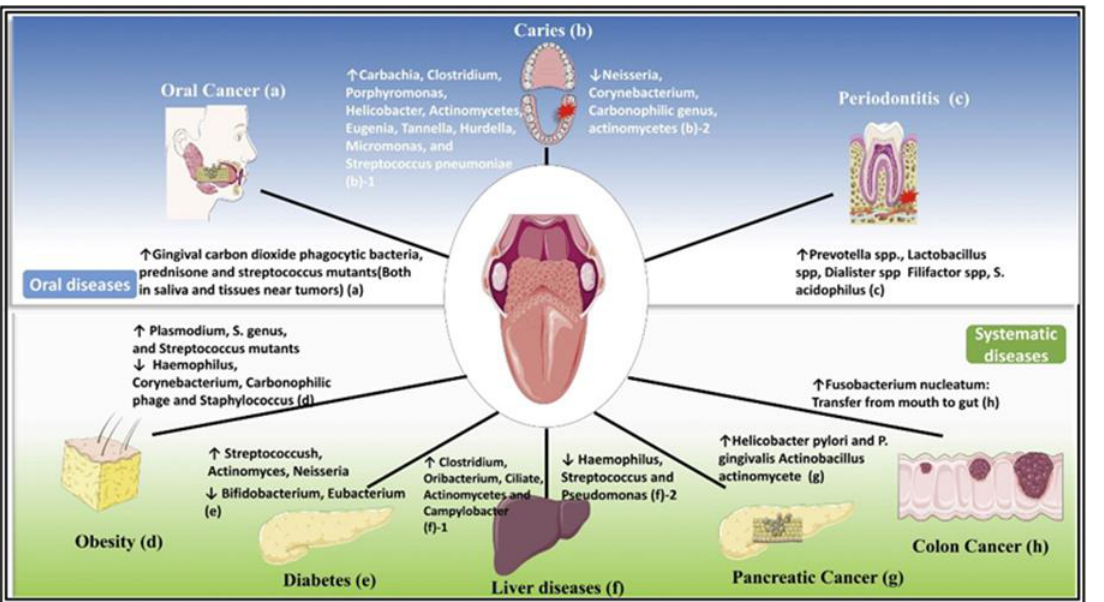
Figure 4. The oral microbiota is related to oral and systemic diseases. The oral microbiota is altered during oral and whole-body diseases. Therefore, the oral microbiota will be a new target for the treatment of oral diseases and the improvement of the body’s physical state. Reproduced with permission from Sampaio-Maia et al.